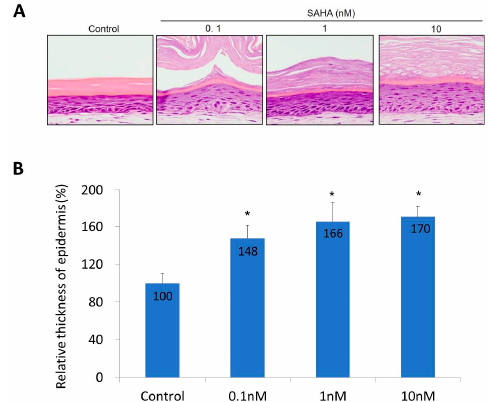
Figure 2. The proportion of p63-positive/HDAC1-negative cells in epidermis. Six areas were randomly selected in each sample and the average percentage was calculated. Statistical significance was calculated with the Mann-Whitney- U test, * p < 0.01 compared with the young-age and p < 0.05 compared with the middle-age group.